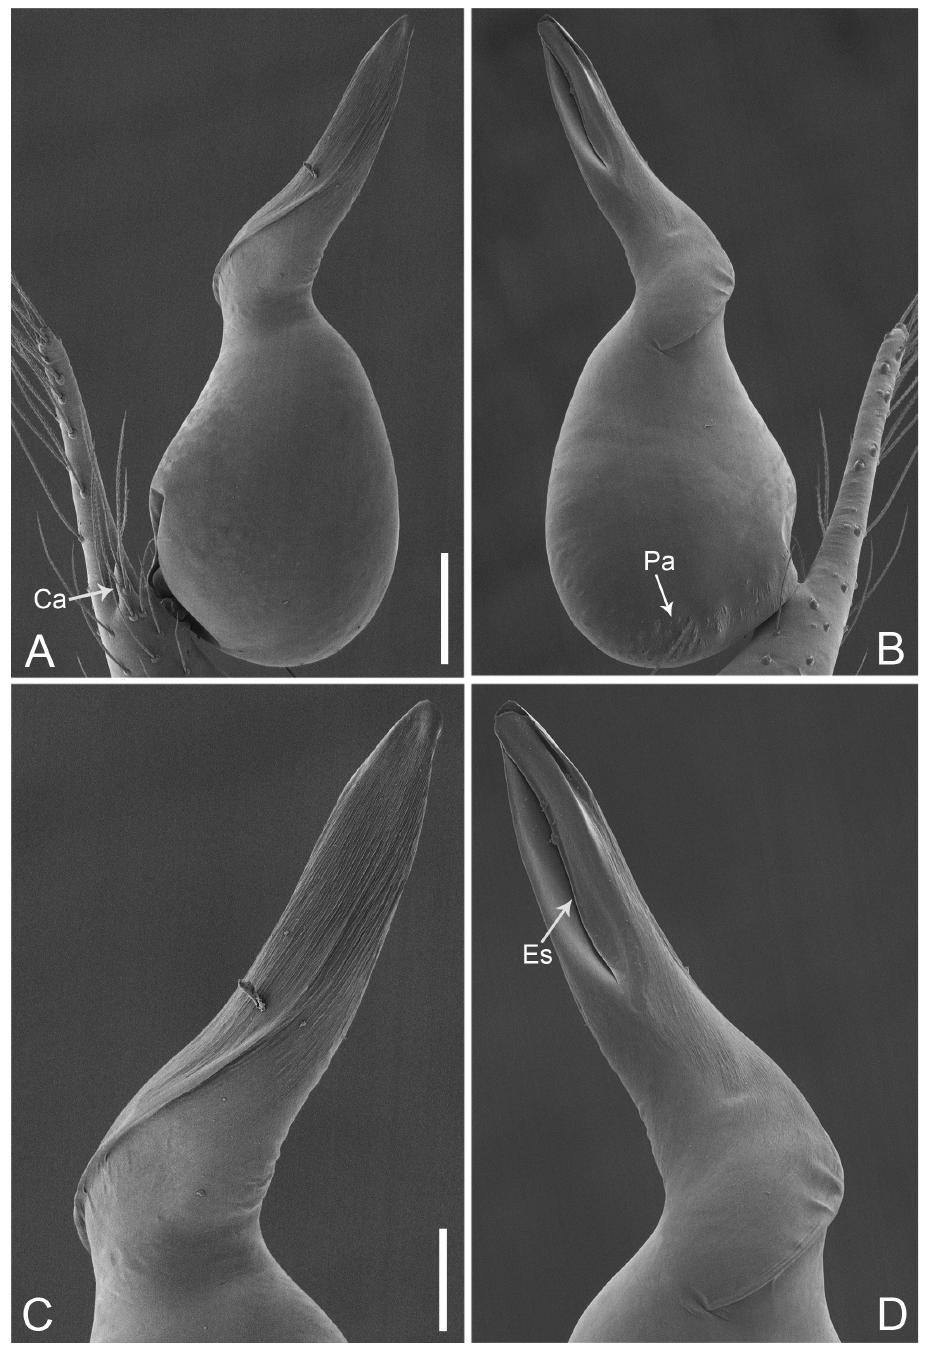
Figure 9. Pinelema liangxi , male. A Palp, prolateral view B Palp, retrolateral view C Embolus, prolateral view D Embolus, retrolateral view. Scale bars: 0.1 mm ( A–B ), 0.05 mm ( C–D